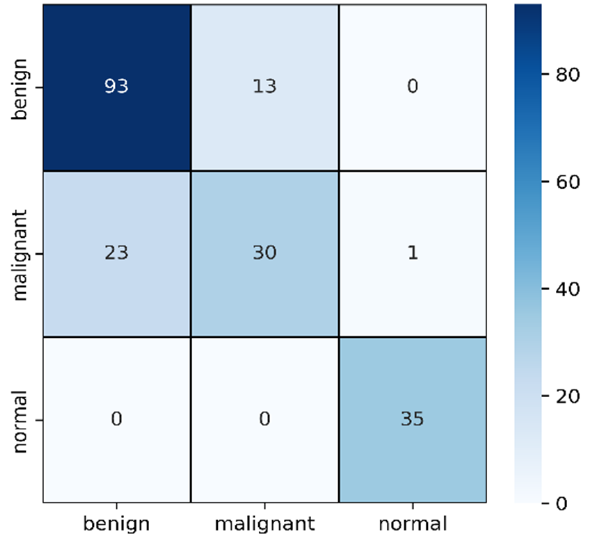
Figure 7. Confusion matrix for masked image evaluation on 25% of test data.